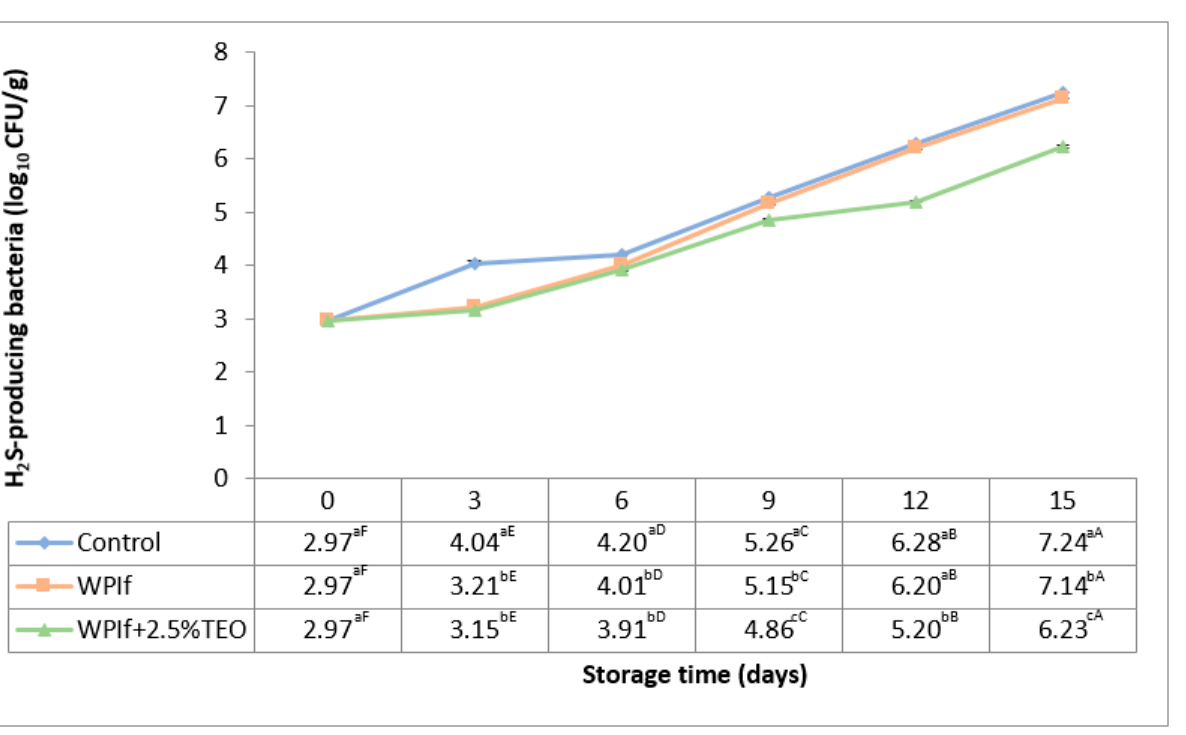
Figure 9. Changes in hydrogen sulfide (H 2 S)-producing bacteria of brook trout samples during refrigerated storage. Control-uncovered fish samples; WPIf-fish samples covered with WPI-based films; WPIf+2.5%TEO-fish samples covered with whey protein isolate-based films incorporated with 2.5% tarragon essential oil. Values are expressed as mean ± standard deviation of two replicates. Means that do not share a letter (lowercase letters on column and uppercase letters on row) are significantly different.